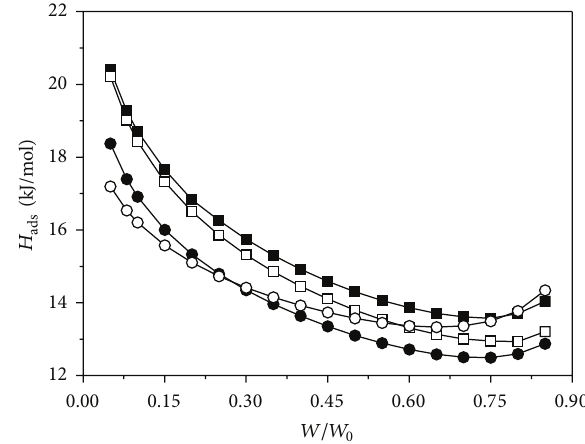
) for methane/carbon spheres ads